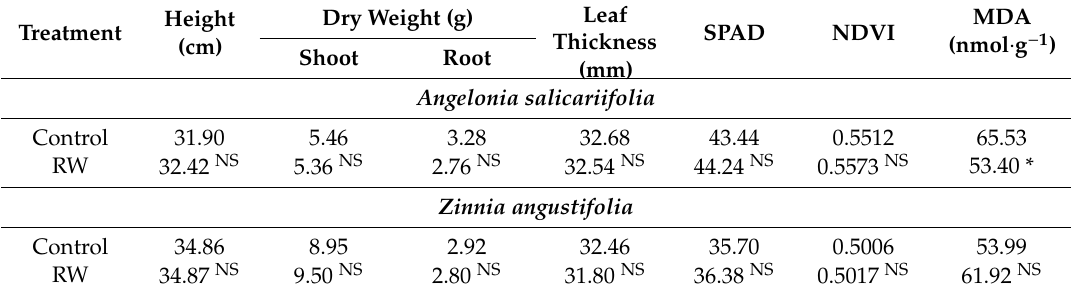
Table 2. E ff ects of seven days of waterlogging with simulated reclaimed water (RW) on plant characteristics and physiological indices of Angelonia salicariifolia and Zinnia angustifolia .